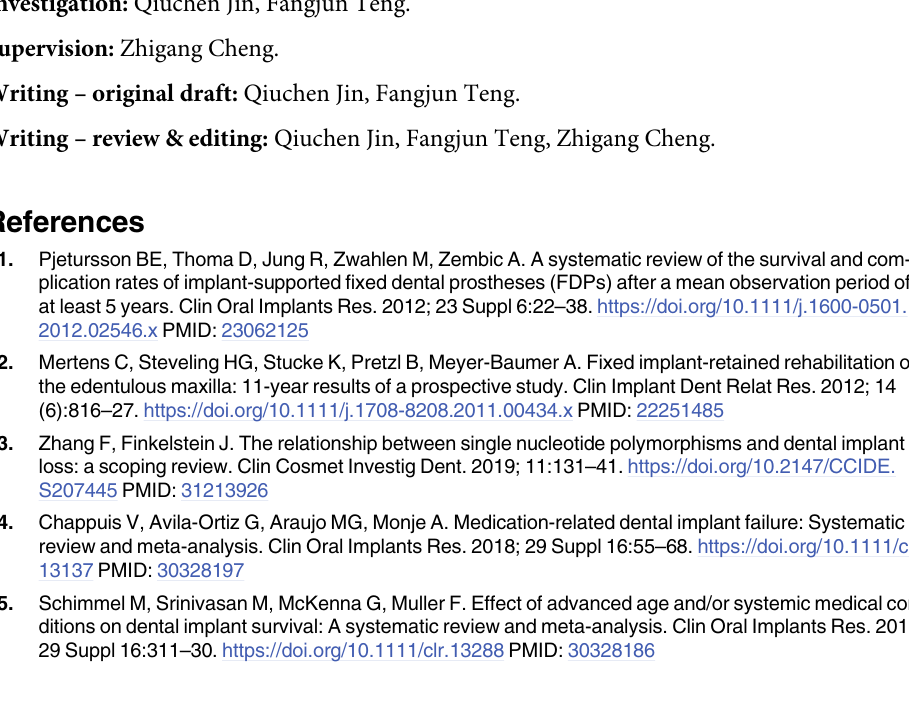
S2 Table. Detailed search